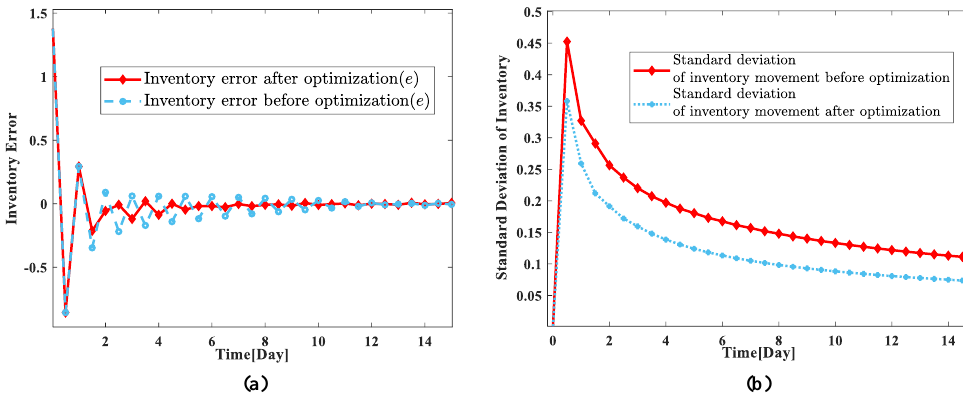
Figure 9. Comparison of inventory error and inventory movement standard deviation before and after parameter tuning. ( a ) Inventory error; ( b ) inventory movement standard deviation.